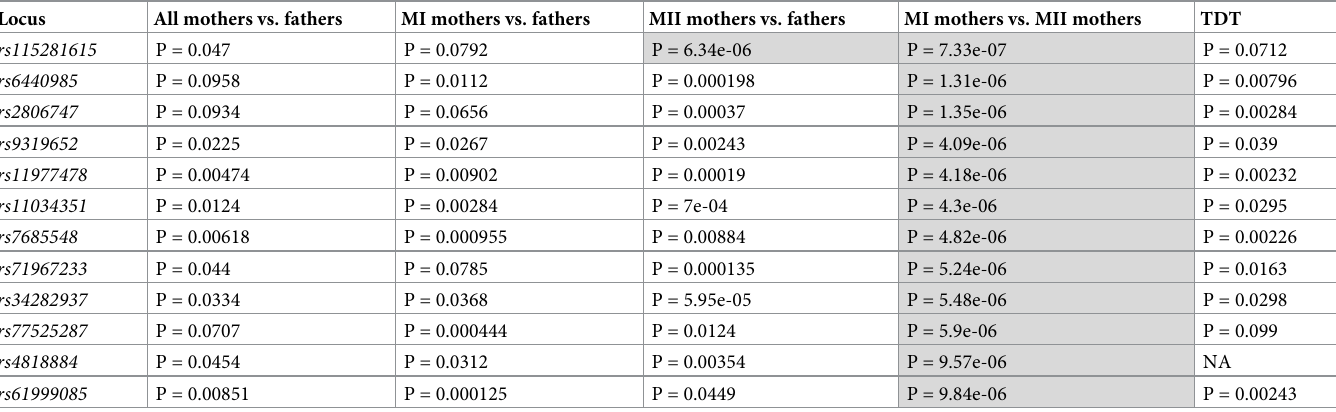
Table 6. Top hits from the MI mothers vs. MII mothers genome-wide association study. Locus All mothers vs. fathers MI mothers vs. fathers MII mothers vs.